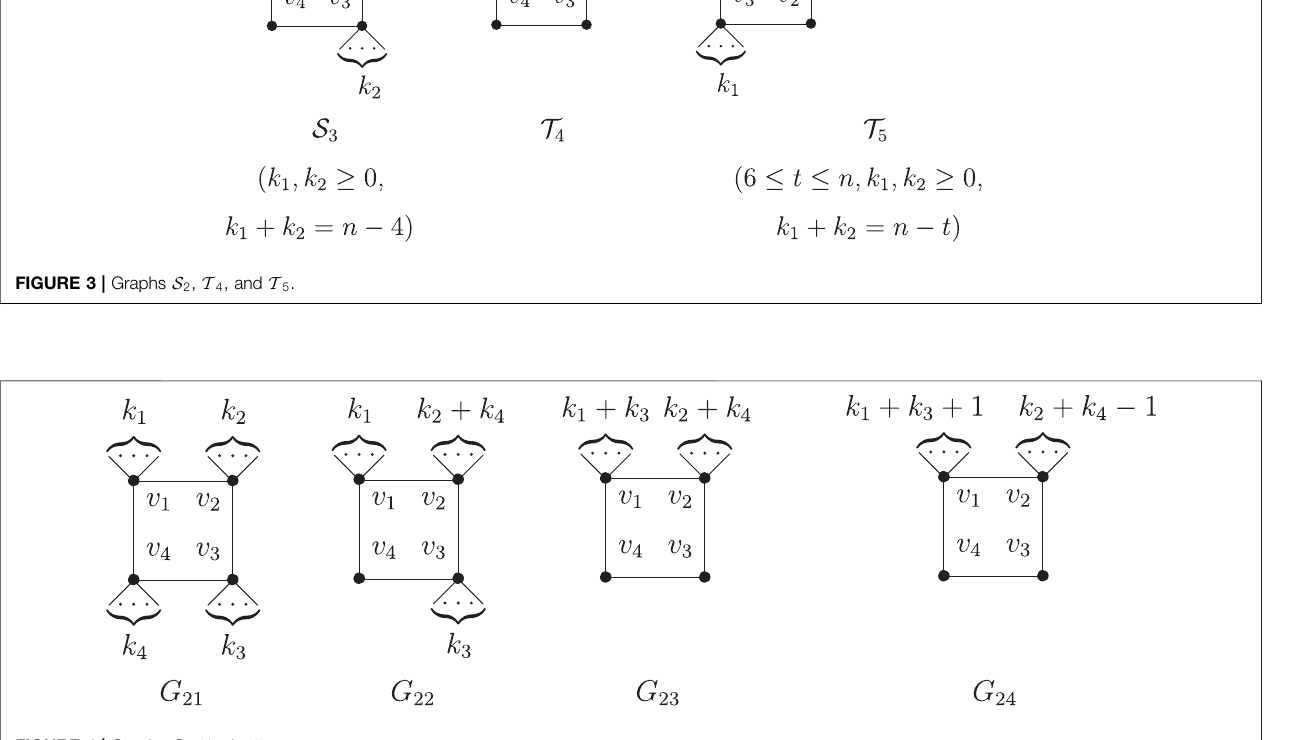
FIGURE 4 | Graphs G 2 i ( 1 ≤ i ≤ 4 )